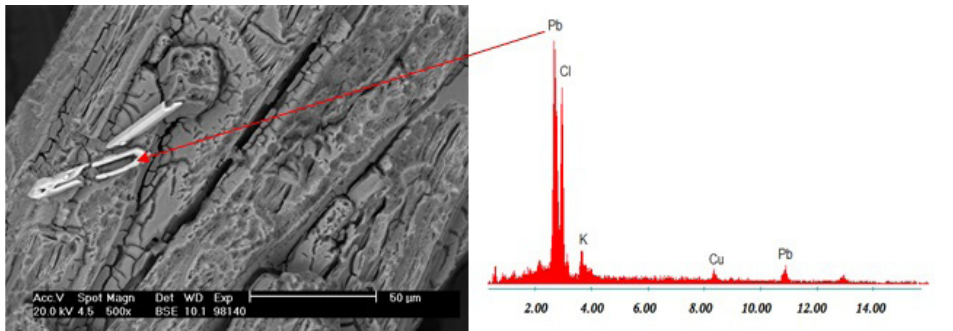
Figure 4 : SEM (left) and spot EDX analysis (right) of the sample from Process 6. The bright lead particles are visible in the SEM image and also in the EDX spectrum.